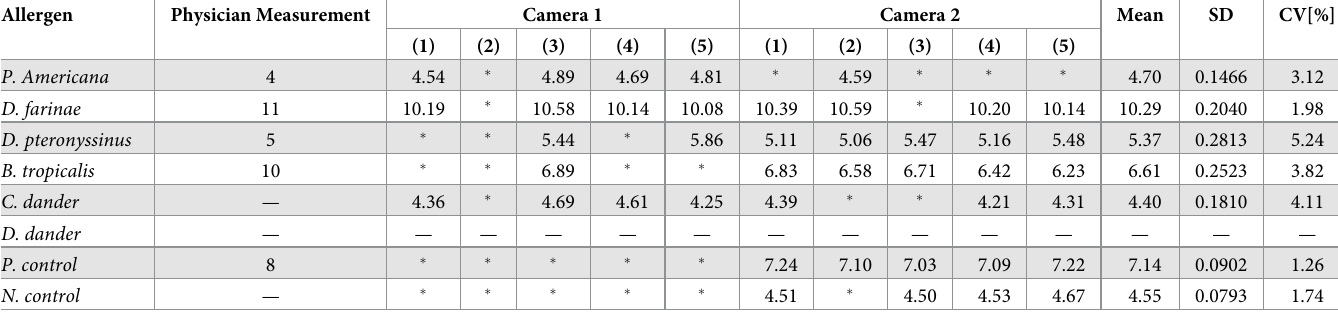
Table 3. Results of the skin prick test. Measurements are reported in millimeters. Allergen Physician